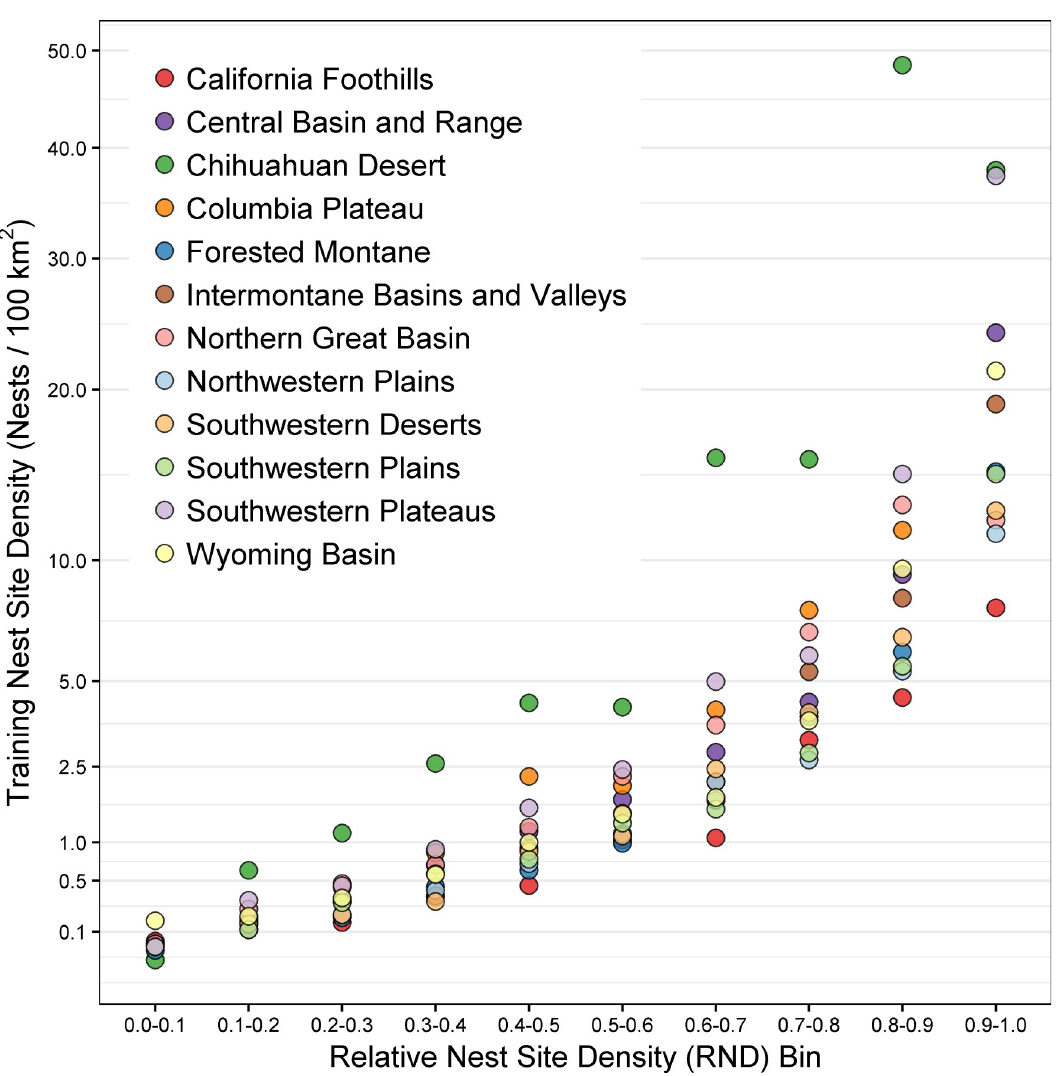
Fig 8. Observed densities of golden eagle nest sites used in model training within ten equal-sized relative nest site density (RND) bins, for each of twelve modeling